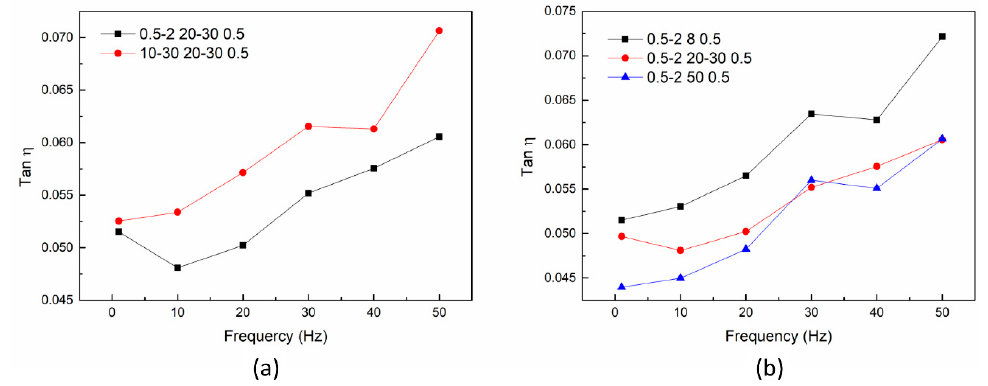
Figure 7. Relationship between loss factor and dimensions of MWCNTs at the frequency range of 1– 50 Hz: length ( a ); diameter ( b ).